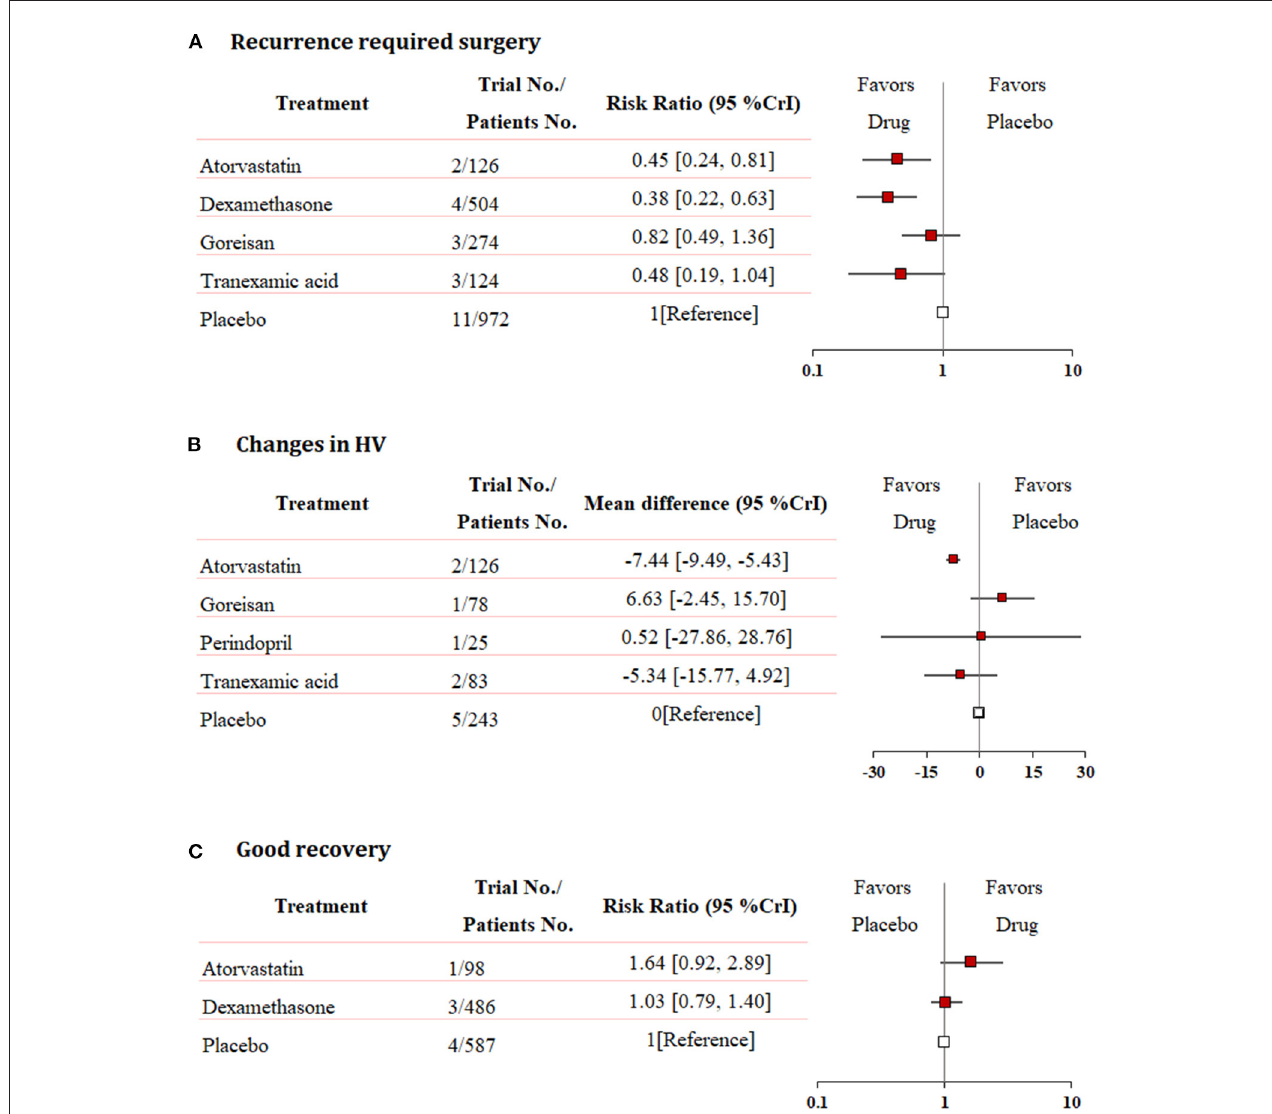
FIGURE 3 | Network meta-analysis of efficacy outcomes. (A) Recurrence requiring surgery, (B) changes in hematoma volume, and (C) good recovery. Each medication is compared with placebo (reference). RR, relative risk; MD, mean difference; CrI, credible interval; HV, hematoma